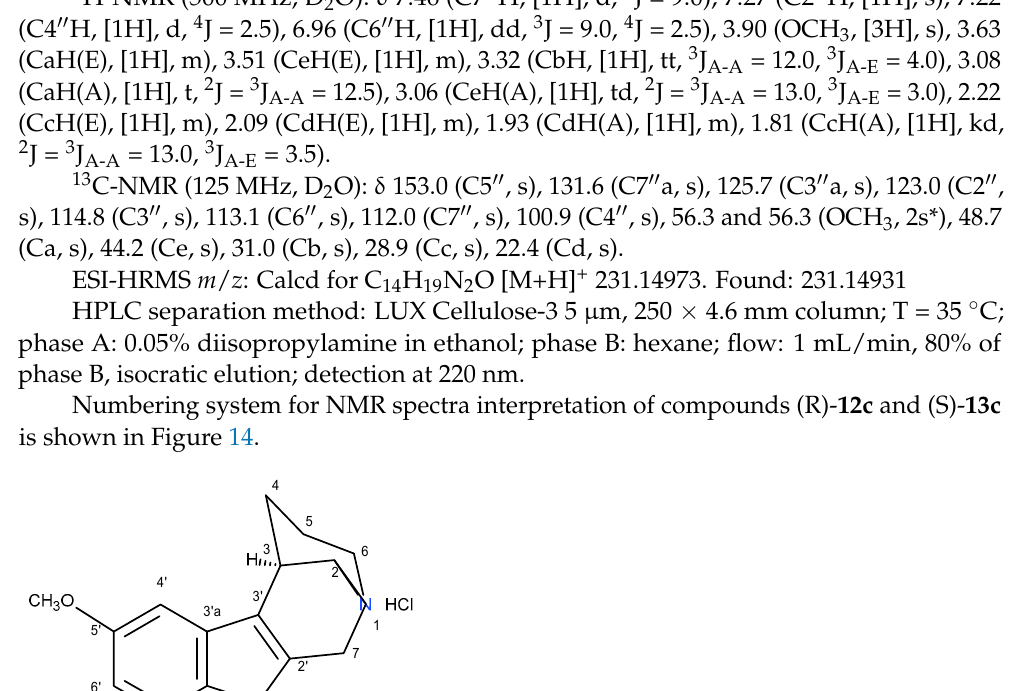
Figure 13. View of molecular structure of enantiomeric fluoro- derivative (S)-11b .